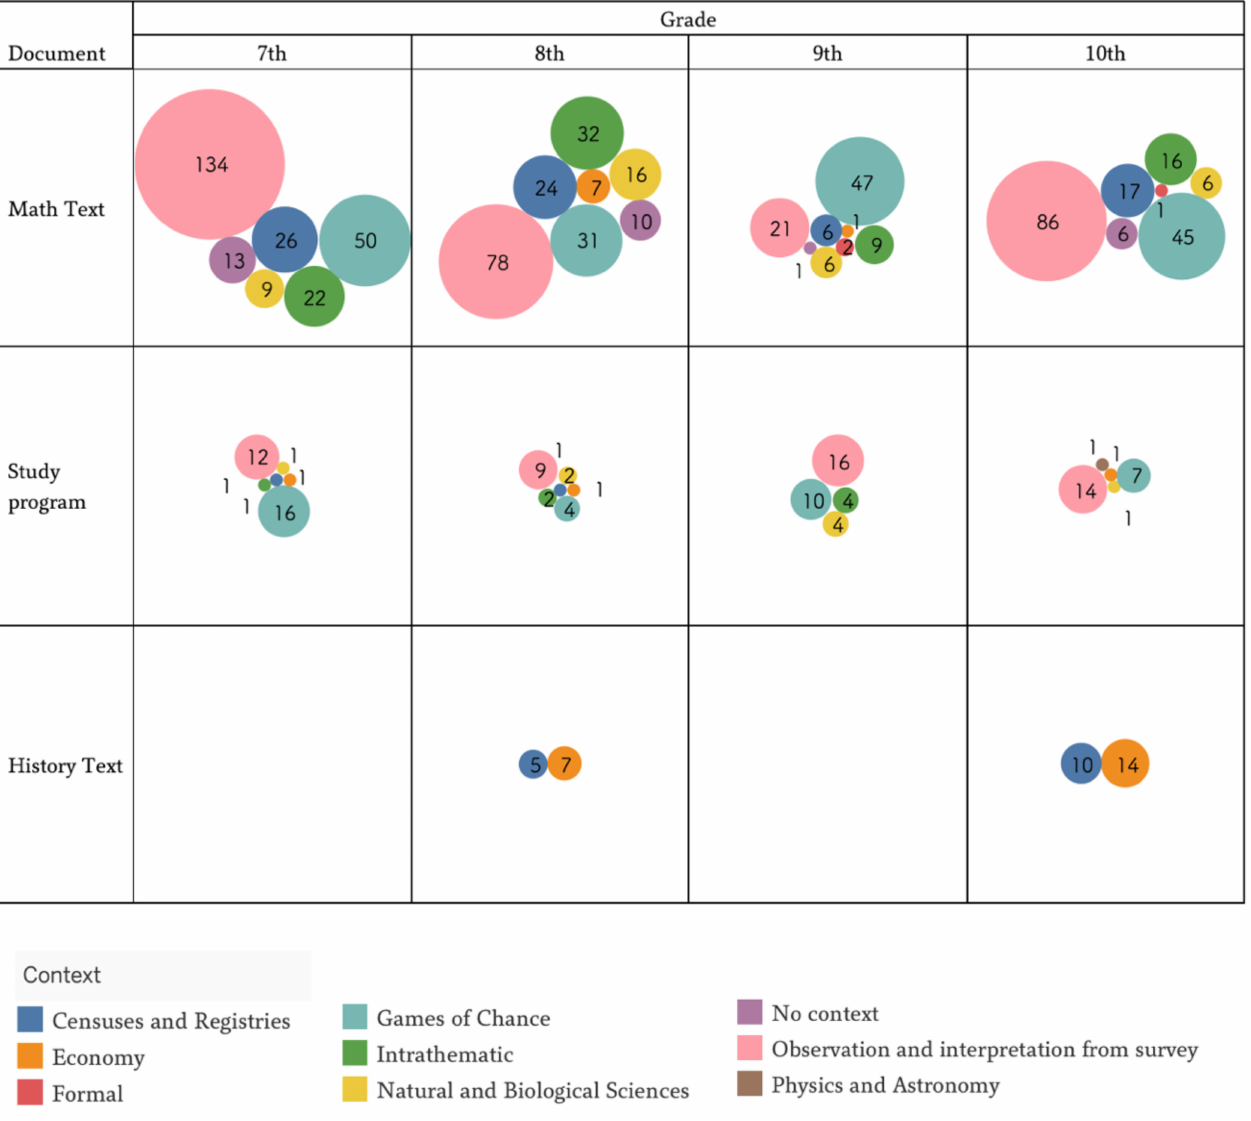
Figure 19. Presence of variable types (Source: Prepared by the authors). Again, history texts emerge as an interesting alternative in the diversification of contexts, because it was possible to observe tasks linked to economics and censuses and records with a national stamp. For example, in Figure 20, we observe a task in which a historical context of Chile is presented linked to the change in fiscal spending in sectors such as education, health, defence and public administration, which could be more attractive to